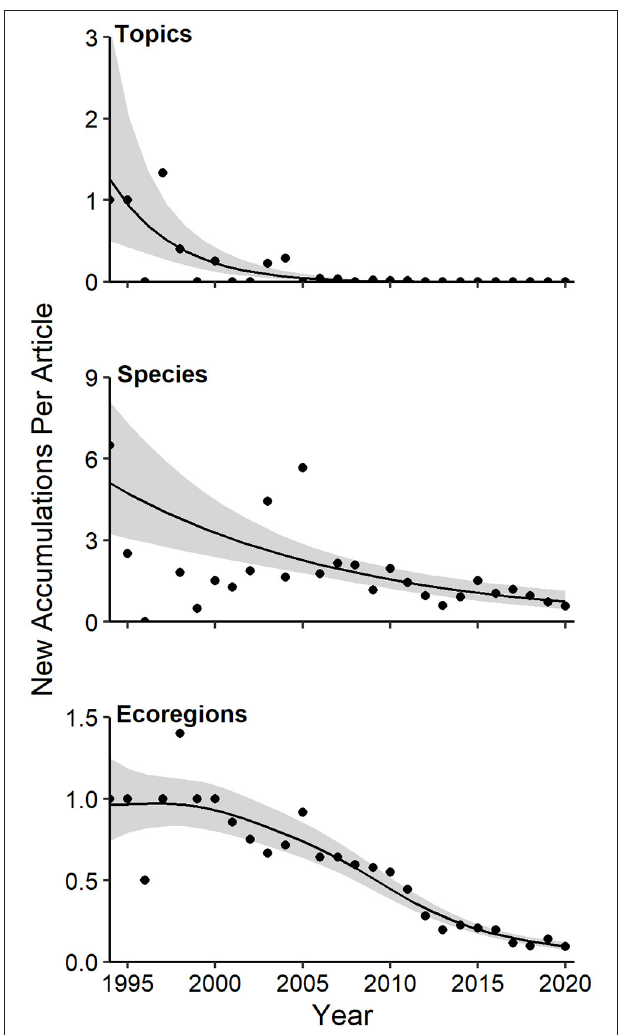
FIGURE 6 | Generalized additive models of Shannon’s diversity index, H , as a function of year. Models were fitted for topics, major taxa, and families of carnivores in camera-trapping articles. Details of model fit are provided in the text and Supplementary Table 1b . Shaded regions represent standard errors and points represent observed indices for each time